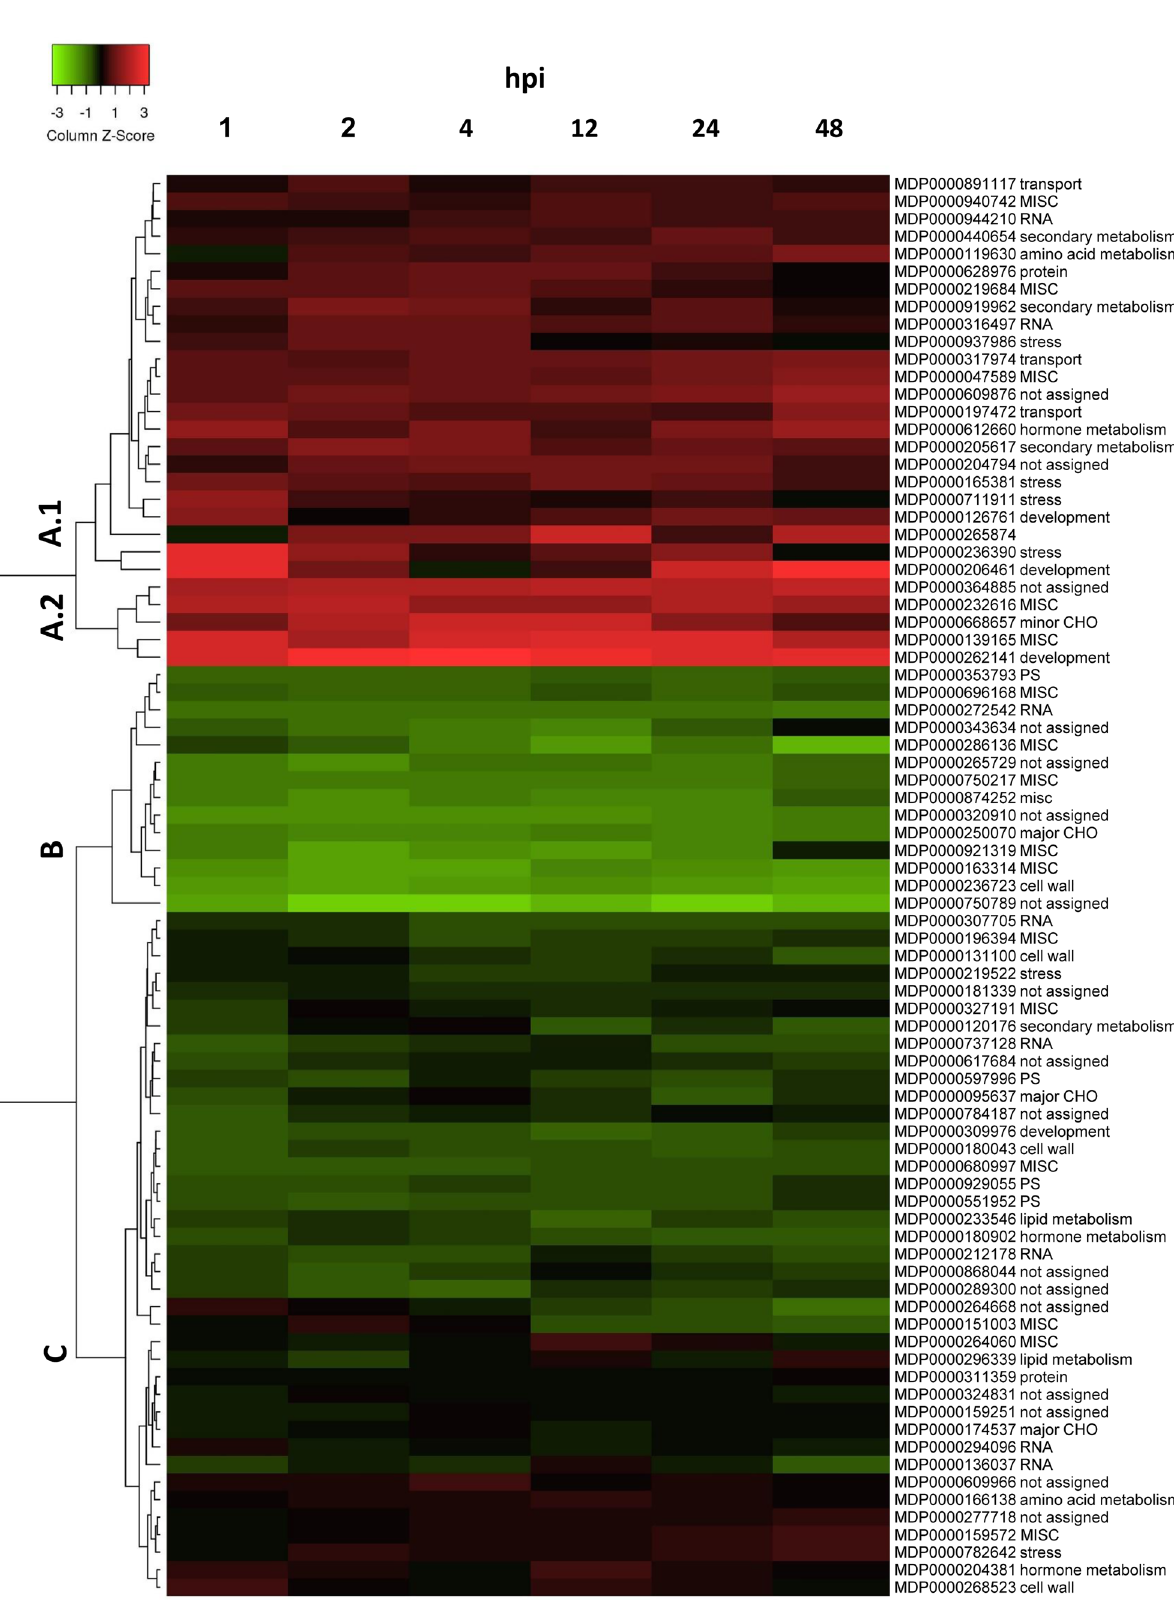
Figure 3. Change of expression of DEGs during resistant reaction. Mr5 plants were inoculated with the avirulent Ea1189 wild type strain and the expression of selected genes was determined by high-throughput real-time qPCR at 1, 2, 4, 12, 24 and 48 hpi. The heat map represents the mean log2 fold change compared to the non-inoculated control. The cluster A contains 28 genes that exhibited induced expression after inoculation as compared to the non-inoculated control whereas 14 genes of cluster B showed a reduced expression. The expression of genes clustered in C was similar to the non-inoculated control. Figure 3 was created using Heatmapper Tool (http:// www. heatm apper. ca/ expre ssion/) and PowerPoint